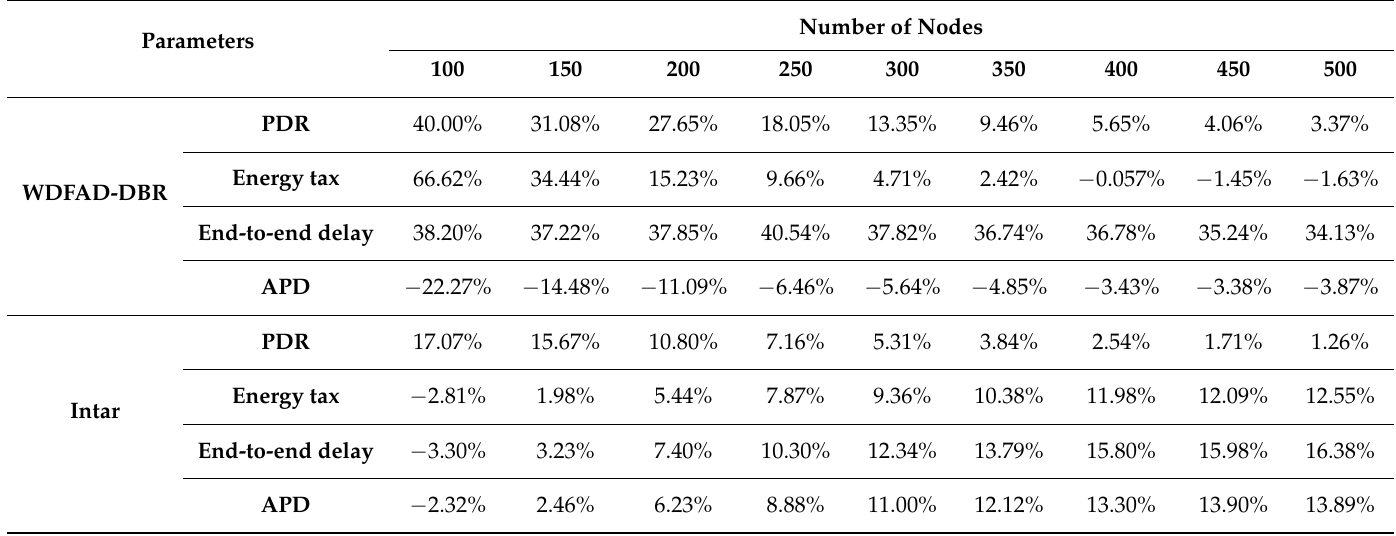
Table 5. Performance trade-offs made by Re-Intar with WDFAD-DBR and Intar in terms of percentage. Positive sign shows that the performance of Re-Intar is improved over respective protocol and negative sign shows that the performance of Re-Intar is